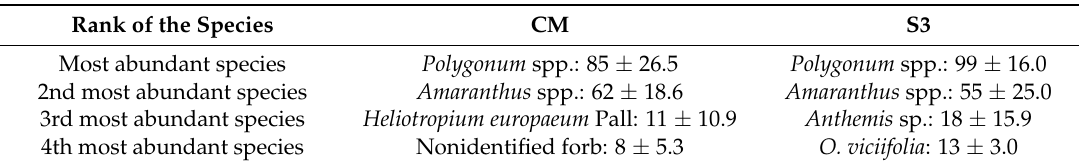
Table 9. Seed density (seeds × litre soil − 1) from the most abundant species found in the different crops (mean ± standard error). CM: cereal monocrop, S3: sainfoin in the third year.